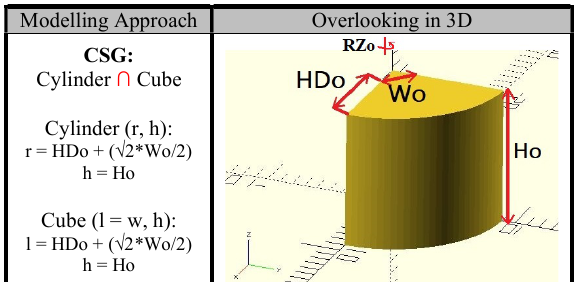
Table 2 . Modelling overlooking LuR based on its identified parameters By considering building height regulation and its identified parameters, it can be geometrically modelled by extruding 2D polygons of zoning base map using Hb values in each zone. Table 3 shows building height regulation in 3D with its identified parameters.